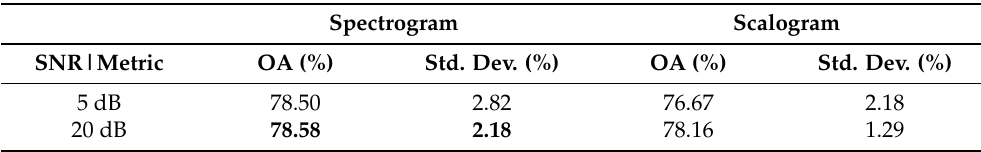
Table 10. The overall accuracy and standard deviation for classification of the inside of the target. The largest average overall accuracy (OA) and corresponding standard deviation (Std. Dev.) are denoted in